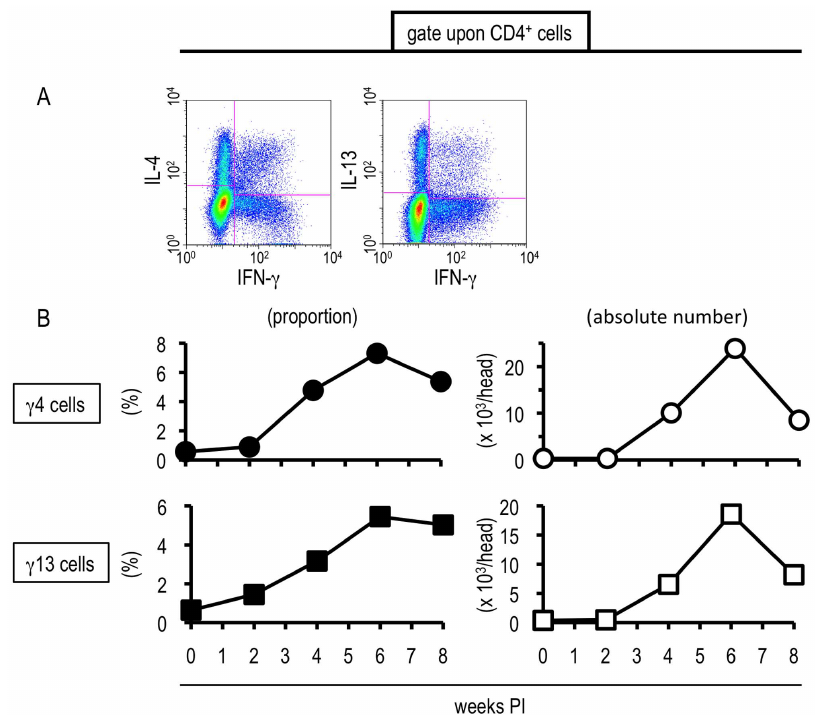
Figure 3. S.mansoni infection-induced hepatic T cells exhbited the potential to produce uncommon combinations of cytokines. Hepatic lymphocytes were isolated from S. mansoni -infected mice at indicated time points, and the proportions and absolute numbers of c 4 and c 13 cells were investigated by ICS. (A) One example using hepatic lymphocytes prepared at 6 weeks PI is displayed. (B) The percentages represent the proportions in CD4-positive population. This experiment is representative of three independent experiments.